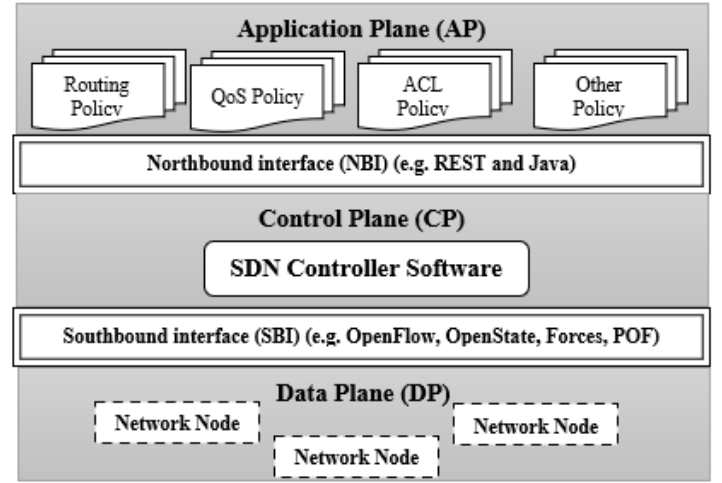
Figure 1. Software defined networking architecture.